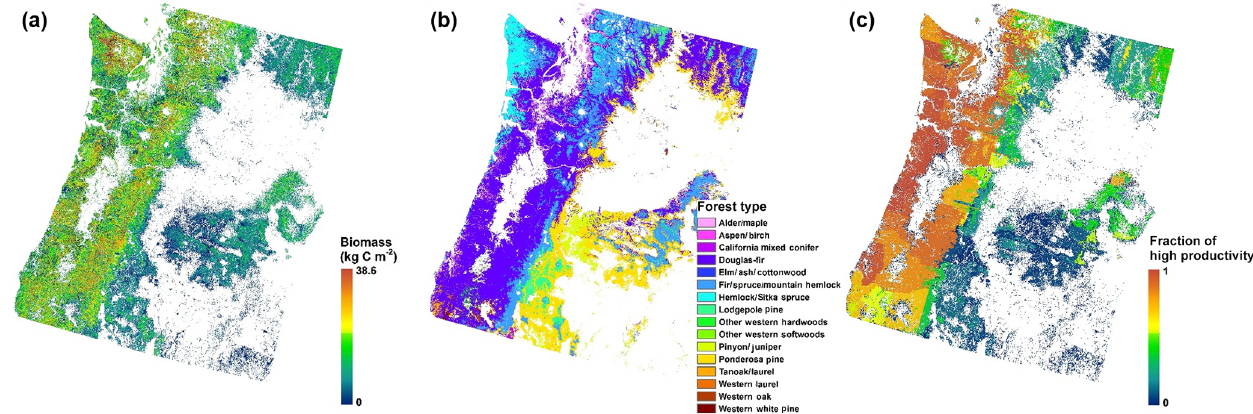
Figure 2. Maps of (a) NBCD 2000 (National Biomass and Carbon Dataset) above-ground biomass, (b) forest-type group and (c) site productivity in the PNW